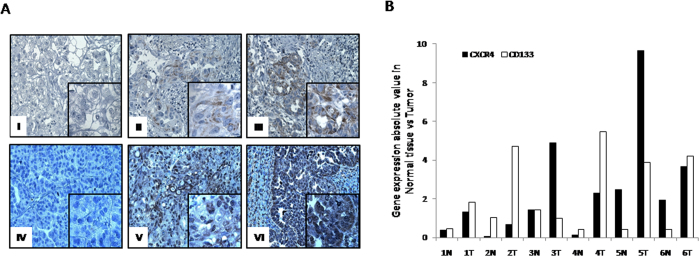
CXCR4 and CD133 are highly expressed in ovarian cancer patients. (A) Representative panel of immunohistochemistry for CD133 and CXCR4 expression (Magnification 200X; insert 400X). Non-homogeneous and focal cytoplasmic and membranous CD133 expression rated as negative (I), focally low (1–10% cancer cells) (II), focally high CD133 expression (>10% stained cancer cells) (III). Extensive homogeneous cytoplasmic and membranous, CXCR4 staining was reported rated as negative (IV) moderate (<50% of cancer cells) (V) and high expression (>50% of cancer cells) (VI). (B) QPCR analysis of CXCR4 and CD133 in freshly resected ovarian tumors and corresponding normal ovarian tissue.